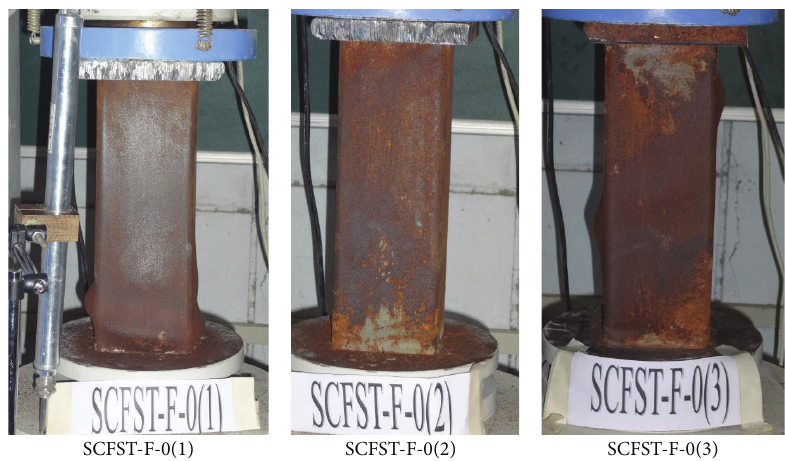
Figure 3: Failure pattern of square CFST column subjected to full